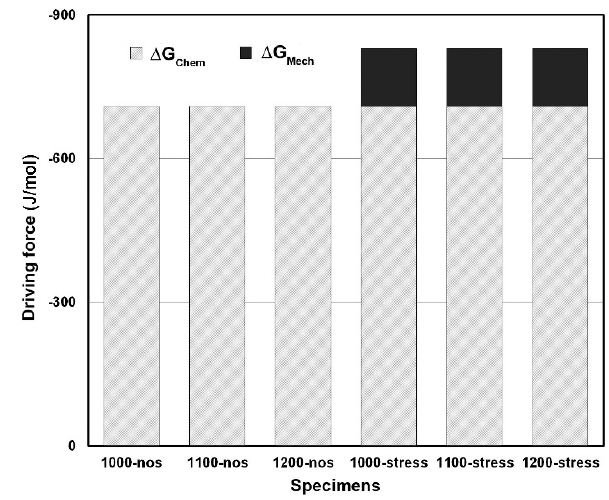
Figure 9. Chemical driving force ( Δ G Chem ) for bainitic transformation at 330 °C in the tested specimens and mechanical driving force ( Δ G Mech ) provided by a stress of 140 MPa for the bainitic transformation.